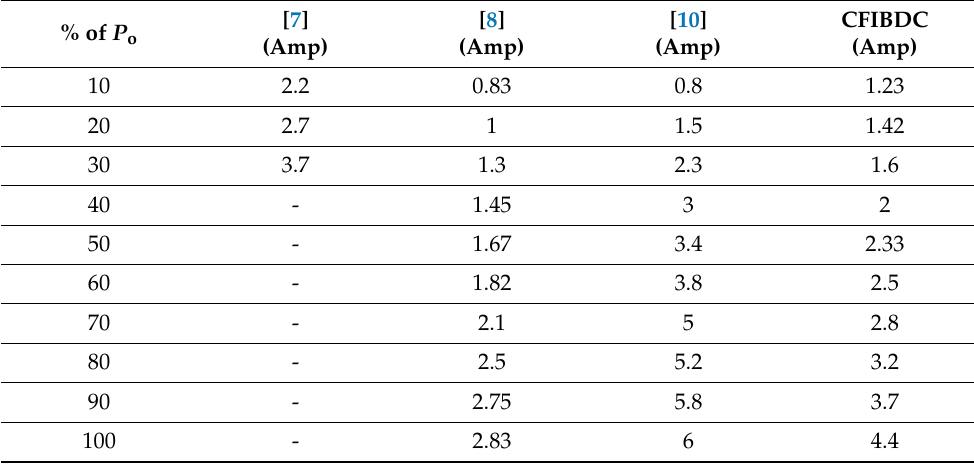
Table 5. Comparison of current stress in different topologies with current stress of proposed converter CFIBDC (Percentage of output power (% P o ) Vs. Current of Topologies given with reference number). % of P